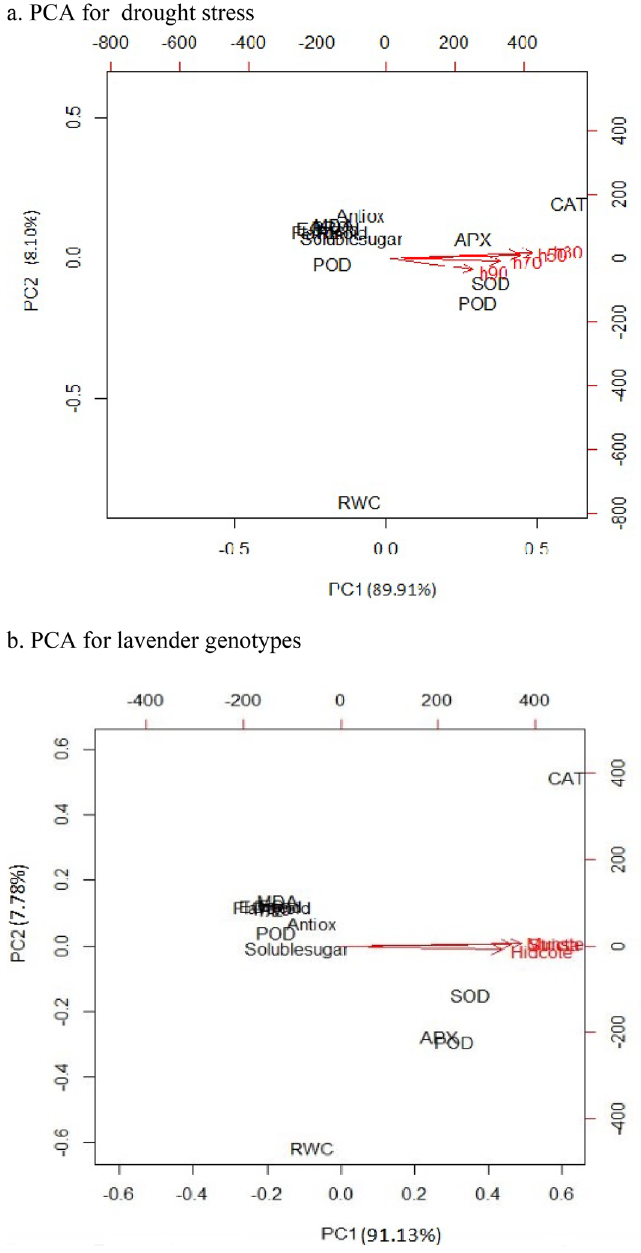
Figure 11. Principal component analysis (PCA) for genotypes ( a ) and physiological traits ( b ) based on water status calculated for physiological traits. (R 4.0.4 packages, https:// rstud io. com/ produ cts/ rstud